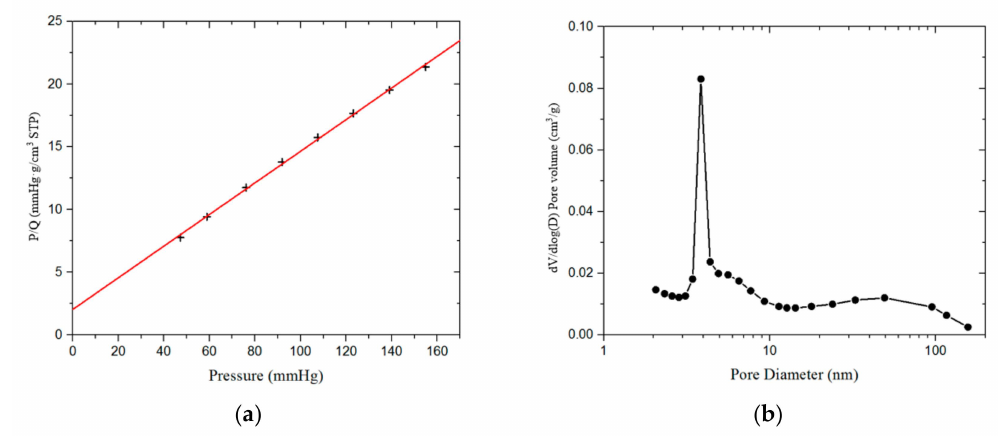
Figure A6. Nitrogen adsorption of sample 4 measured by an ASAP 2420 instrument (Micromeritics). ( a ) Langmuir surface area plot; ( b ) BJH desorption dV / dlog(D) pore